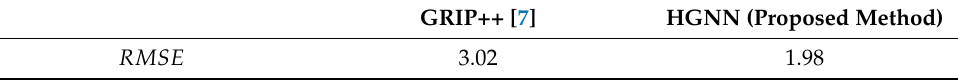
Table 4. Comparison of RMSE errors with GRIP++ in a real driving dataset.